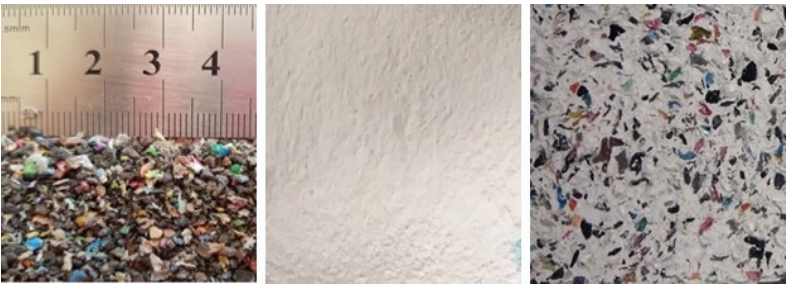
Figure 1. Left, plastic cable waste (PR). Center, sample without PR. Right, sample with PR.